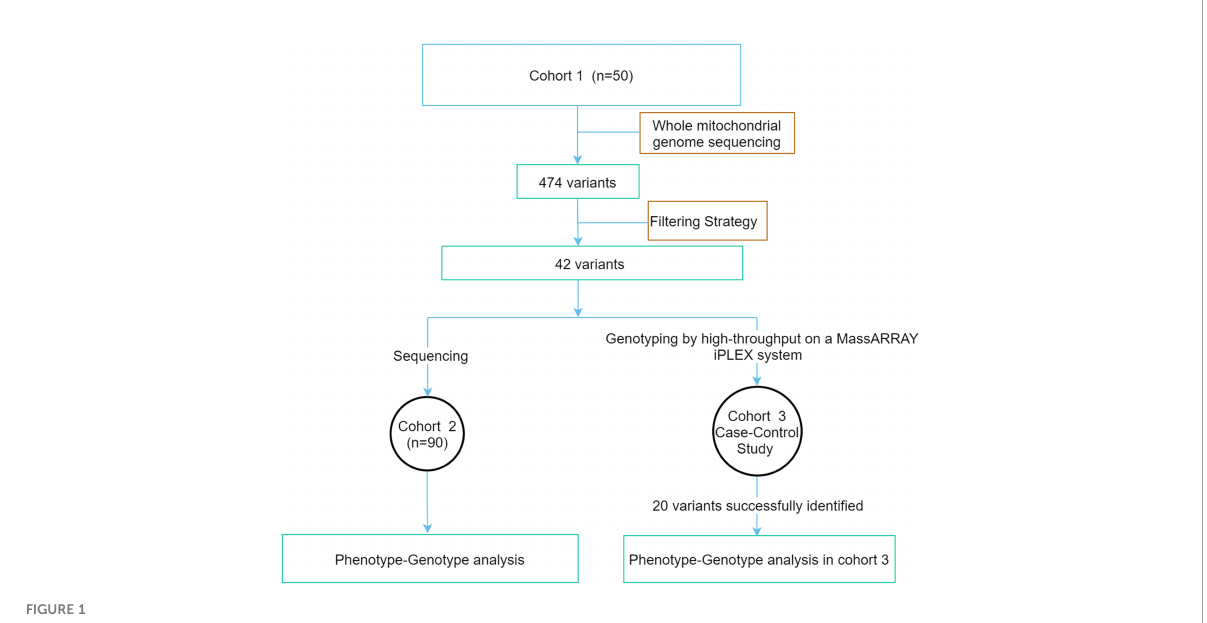
FIGURE 1 The fl owchart of the